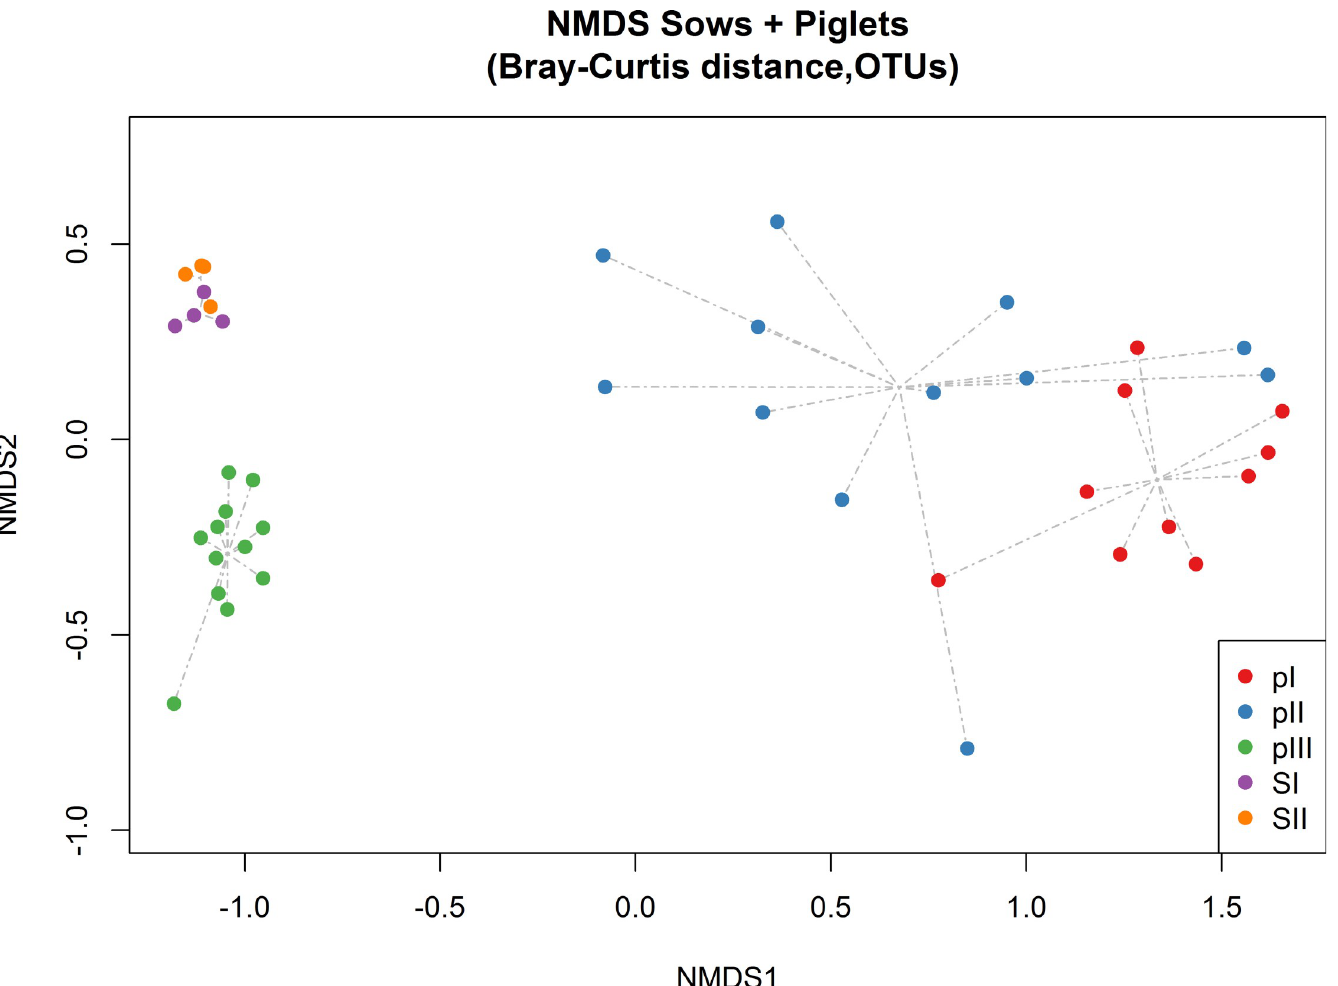
Fig 2. Non-metric multi dimensional scaling (NMDS) on Bray-Curtis distances at OTUs level. pI = piglets timpoint I (day 7 post farrowing), pII = piglets timepoint II (day 14 post farrowing), pIII = piglets timepoint III (day 14 post weaning), SI = sows timepoint I (day 7 post farrowing) SII = sows timepoint II (day 14 post